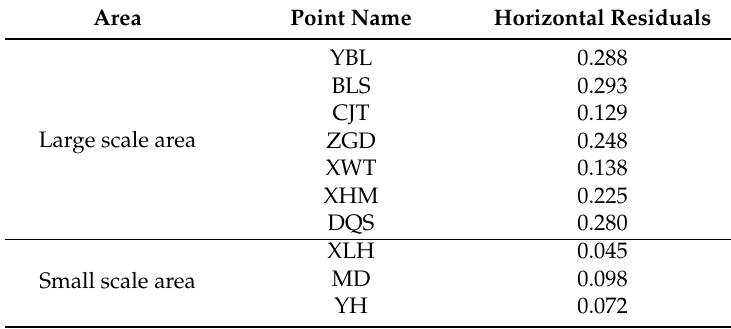
Table 5. The accuracy of coordinate transformation from CGCS2000 to Beijing54